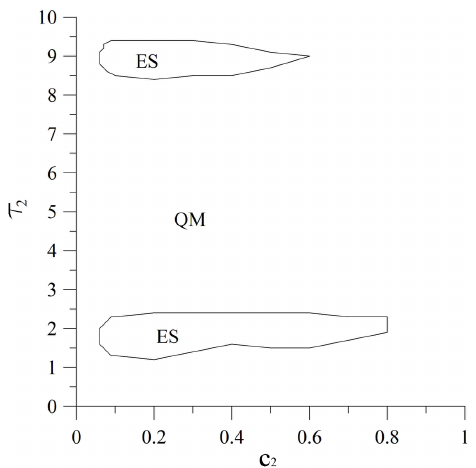
Fig. 7. Parameter domains ( τ 2 ,c 2 ) admitting periodic motion (PM) or quasiperiodic motion (QM) of the second block. c 1 = 0.1 and τ 1 = 3.0 are fixed so that the first block lies in the equilibrium state. Diagram is constructed for the 0.1 step size for both c 2 and τ 2 . Other parameter values are as in Fig. 5. The initial function for U is selected such that its values within the interval [ − τ, 0] are set by Eq. (7) with c 1 = c 2 = 0.